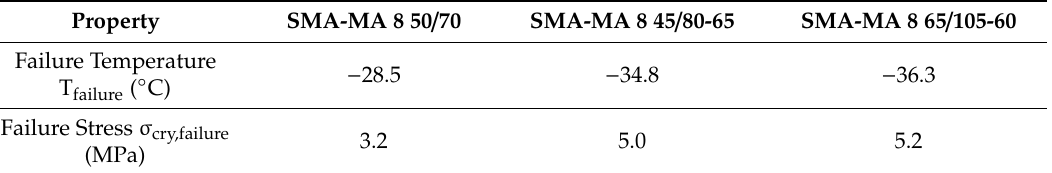
Table 2. Determination of low temperature resistance of MA-MA 8 mixture in the Thermal Stress Restrained Specimen Test